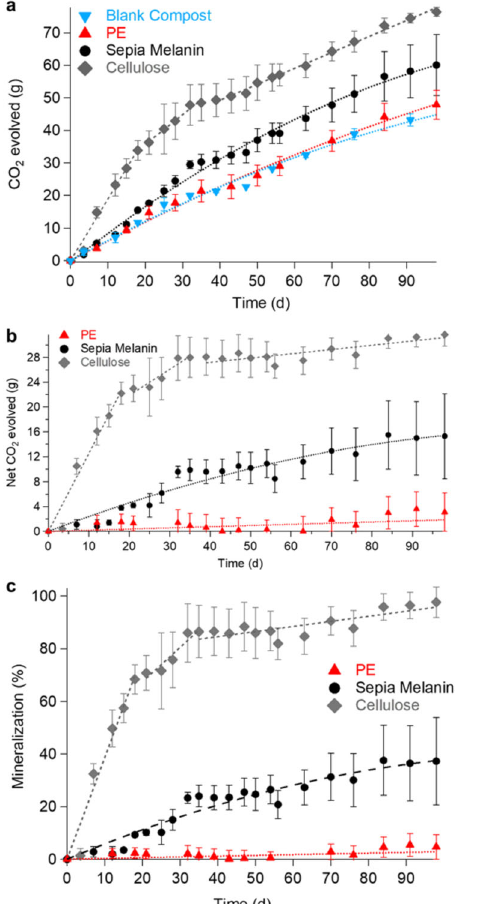
Fig. 3 Biodegradation of Sepia Melanin in composting conditions (58 °C). a Cumulative CO 2 evolved from blank compost, polyethylene (PE), Sepia Melanin, and cellulose. For the blank compost and PE, only half of the points are shown for the sake of clarity, as they overlapped (Supplementary Fig. 3). b Net CO 2 evolved from PE, Sepia Melanin, and cellulose. c Mineralization of PE, Sepia Melanin, and cellulose. Error bars = standard deviation ( n = 3 for PE and Cellulose, n = 2 for blank compost and Sepia